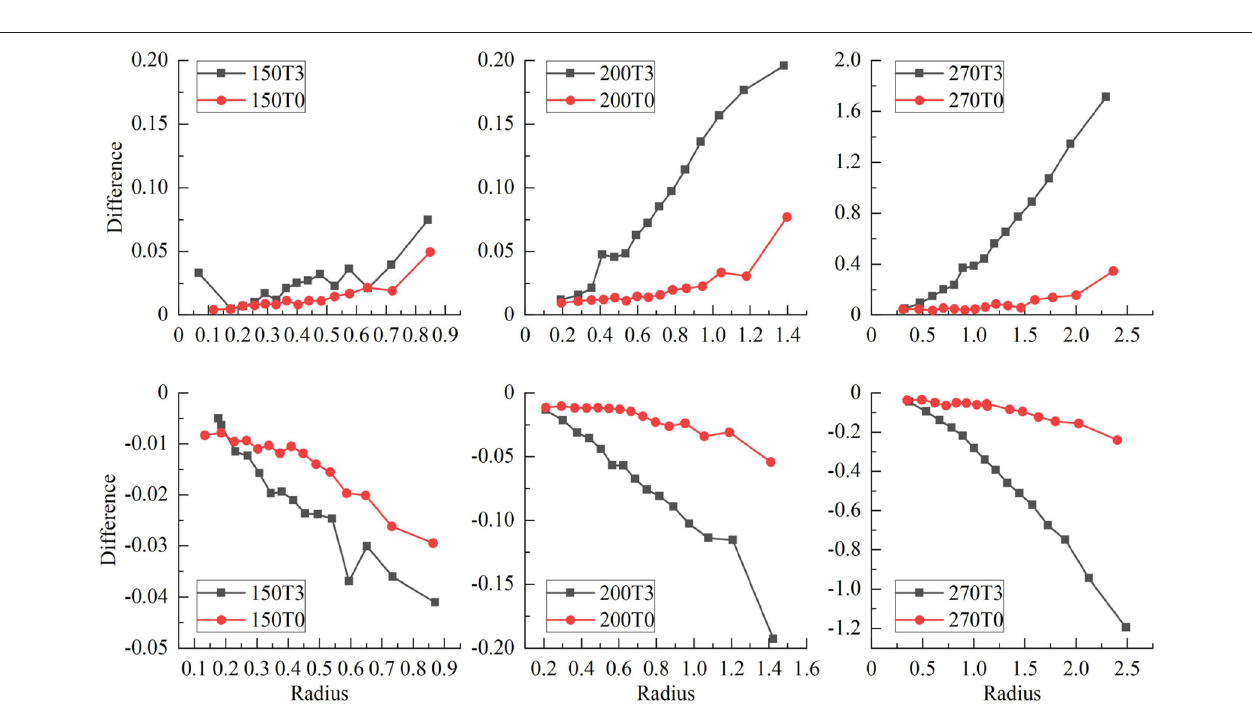
FIGURE 8 | Shows the trend of radius difference between the IC and EC circles as a function of the radius in the standard circle for protons with energies of 150, 200, and 270 MeV.